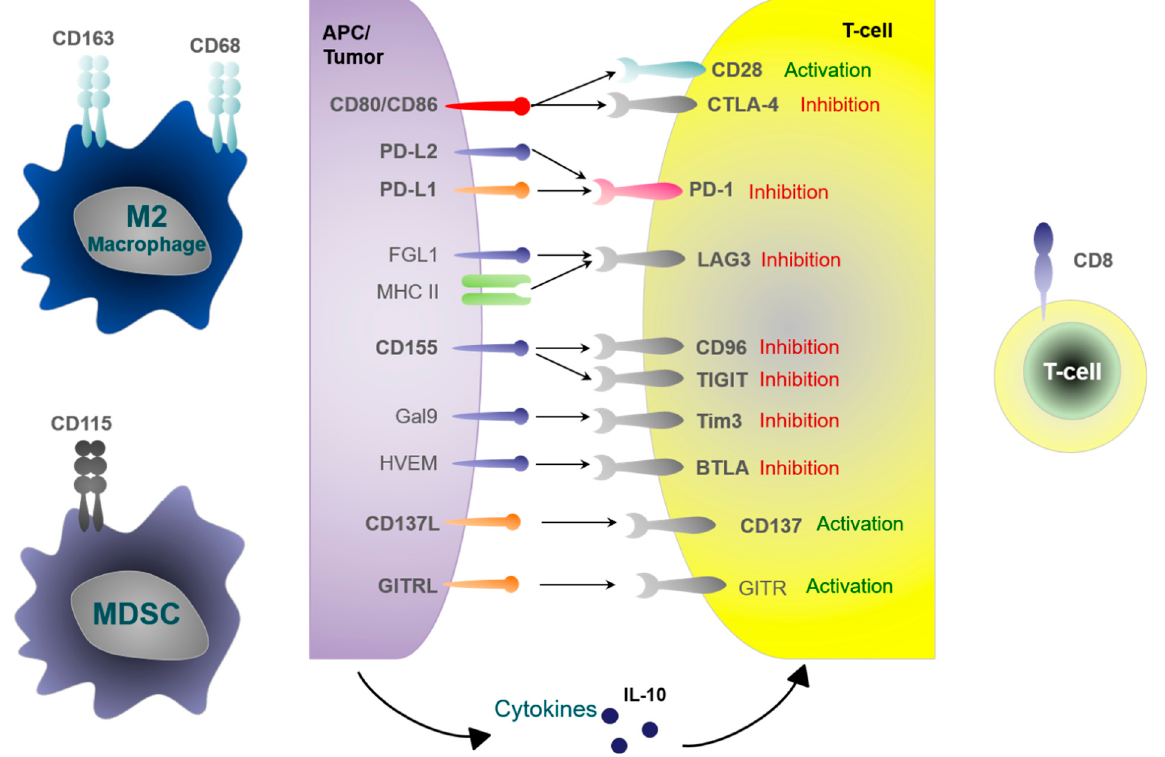
Figure 1. Overview of the cell populations, checkpoint molecules and cytokines analyzed in the study and their interactions to regulate the immune response.